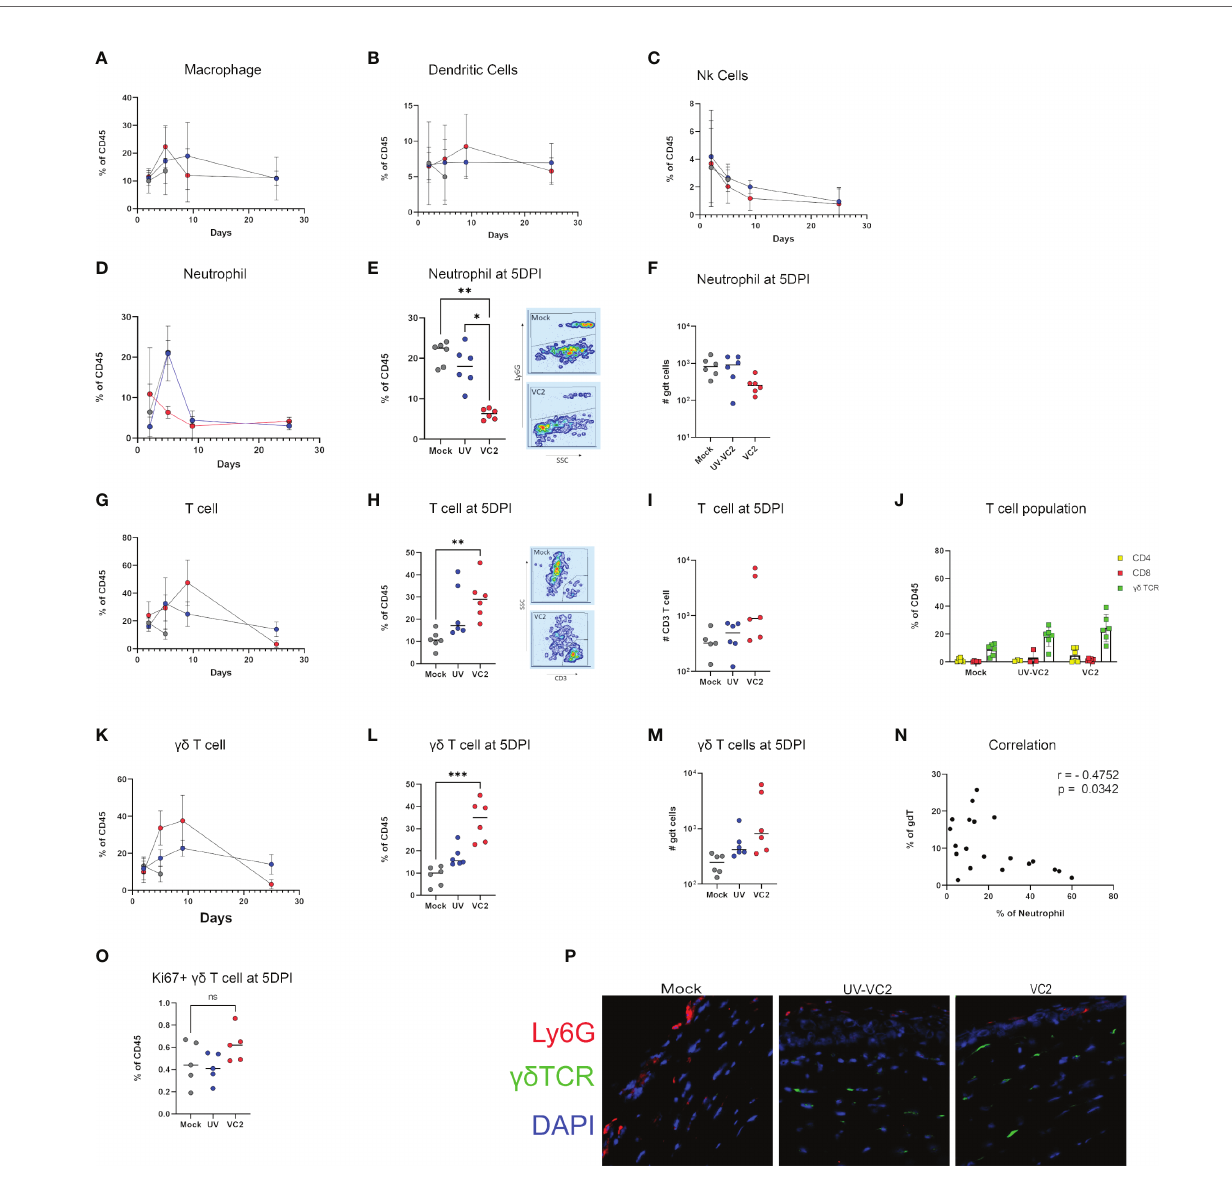
FIGURE 3 | Phenotype of cellular in fi ltrates in ocular tissues following viral challenge. Flow cytometric analysis for cellular in fi ltration for: (A) Macrophage. (B) Dendritic cells. (C) NK cells over time. (D) Percentage of neutrophil accumulation over time. (E, F) Percentage and absolute count of neutrophils at 5DPI. (G) Percentage of T cell accumulation over time. (H, I) Percentage and absolute count of T cells. (J) Phenotype of T cells in individual groups. gd T cell accumulation over time (K) , percentage (L) and absolute count (M) at 5DPI. (N) Spearman's rank correlation between gd T cell and neutrophil accumulation among all groups. (O) Ki67+ gd T cell in cornea. (P) IFM for the presence of neutrophils and gd T using OCT section. **<P=0.005, ***<P=0.001 using One-Way ANOVA,